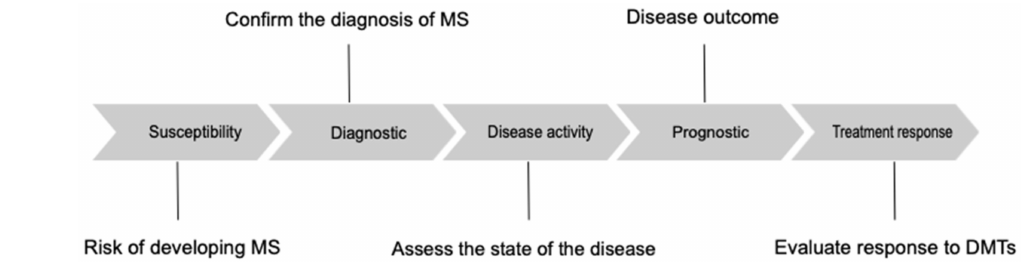
Figure 1. Different types of biomarkers in multiple sclerosis. DMTs, disease-modifying